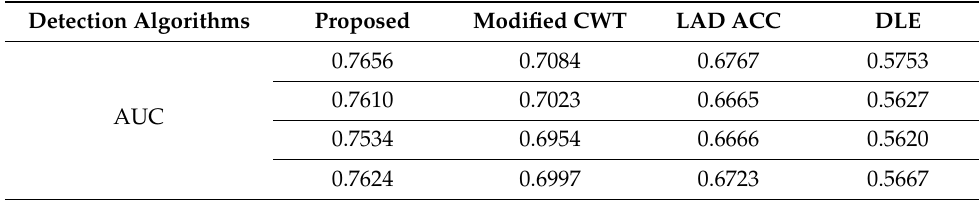
Table 2. Results of the AUC for different detection